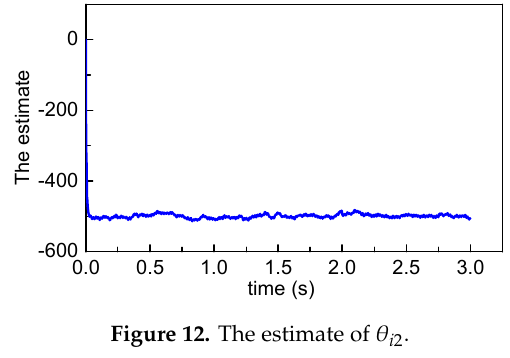
Figure 11. Tracking error using sliding mode control (SMC).